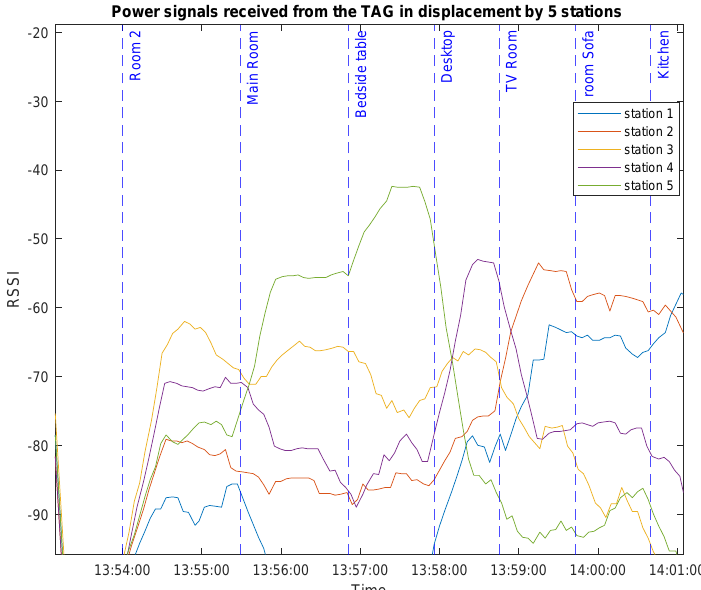
Figure 10. Received RSSI values for the corresponding broadcast messages sent by the TAG at different locations (taken from